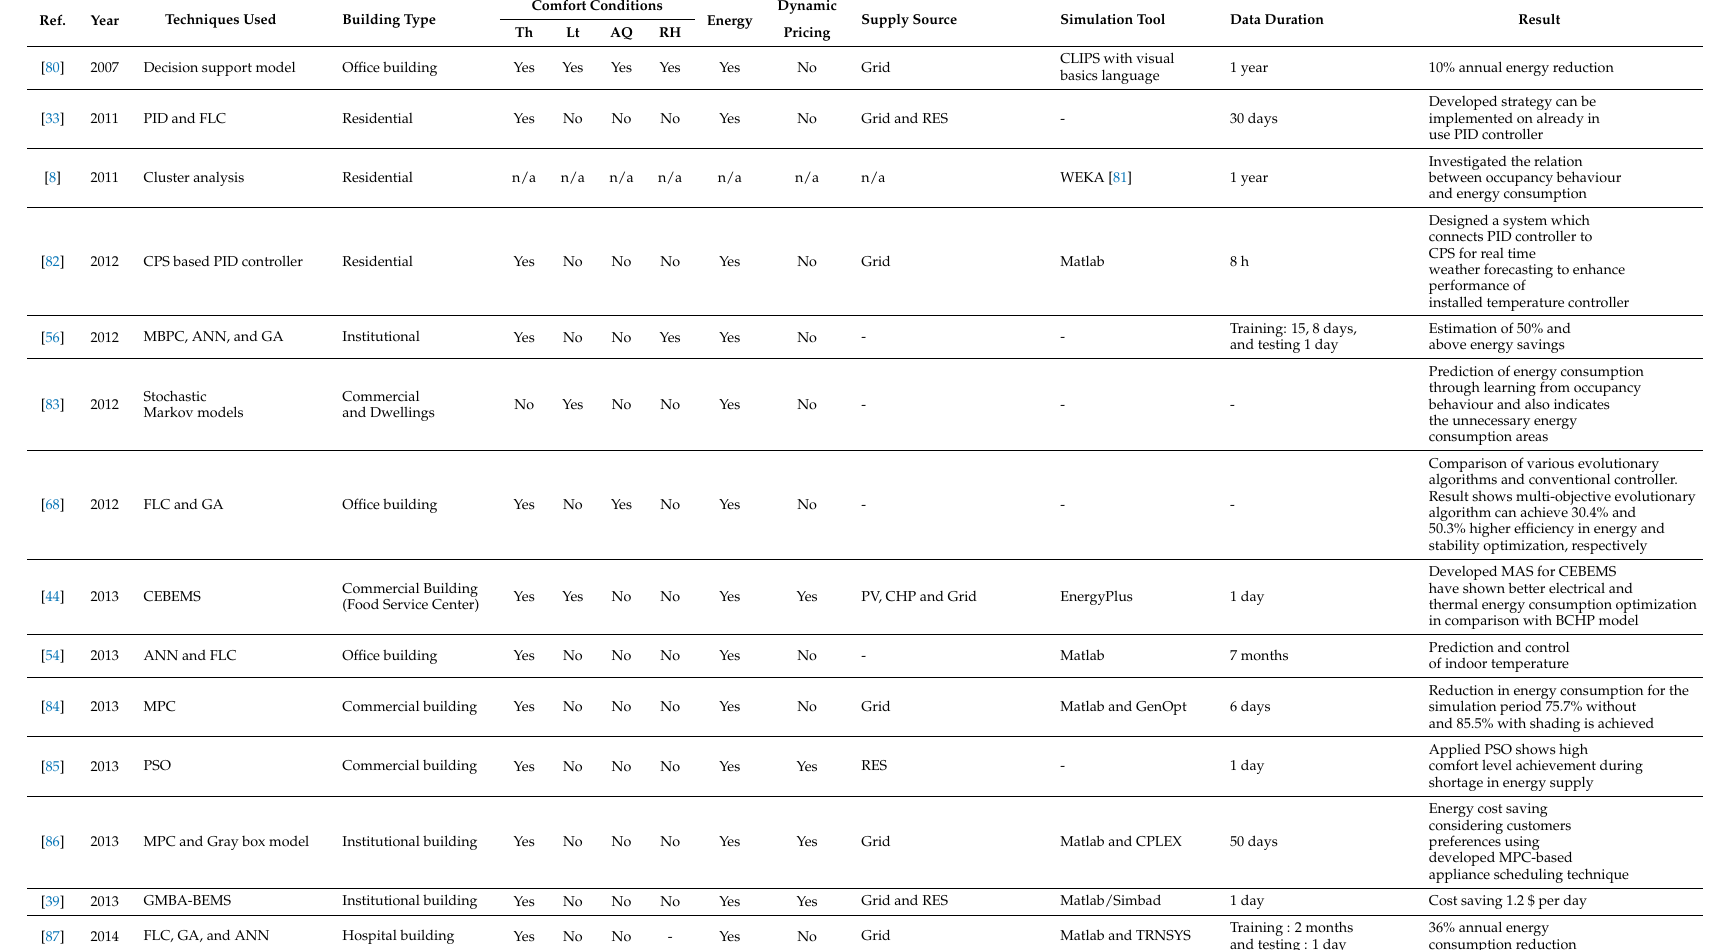
Table 3. Literature review